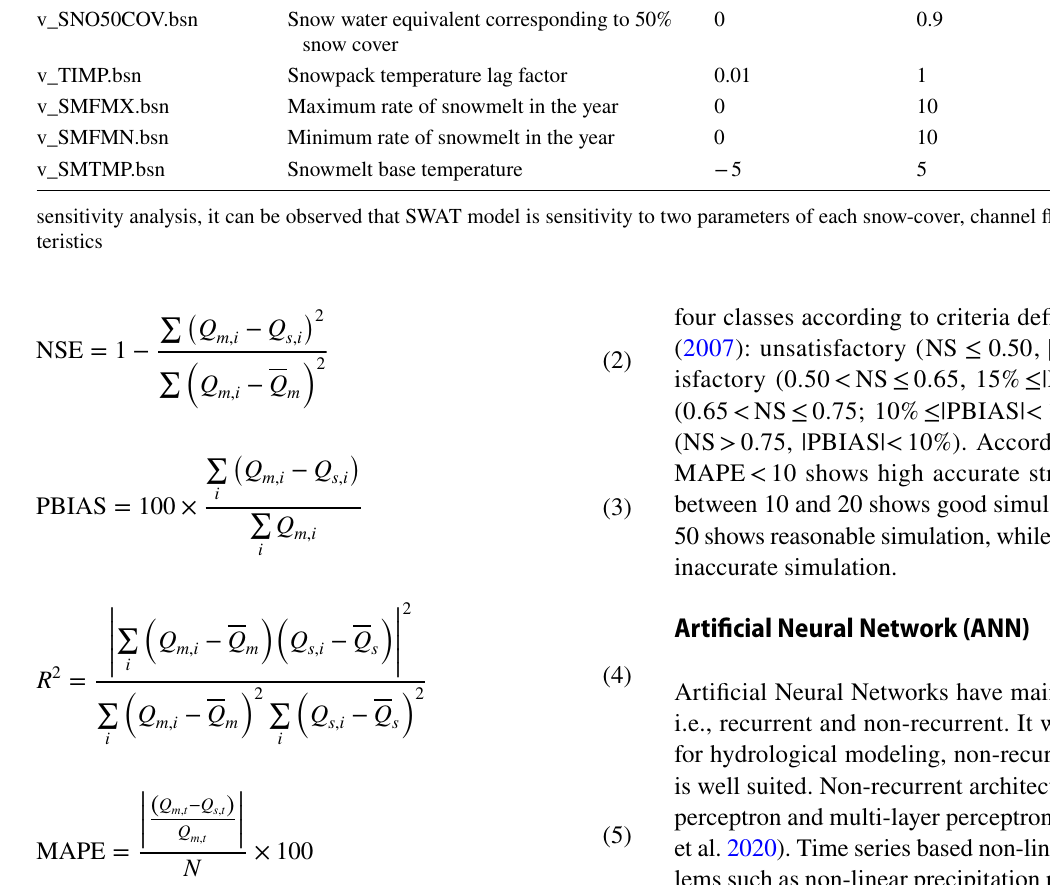
values by new selected values, and relative change to the initial values of selected parameters, respectively